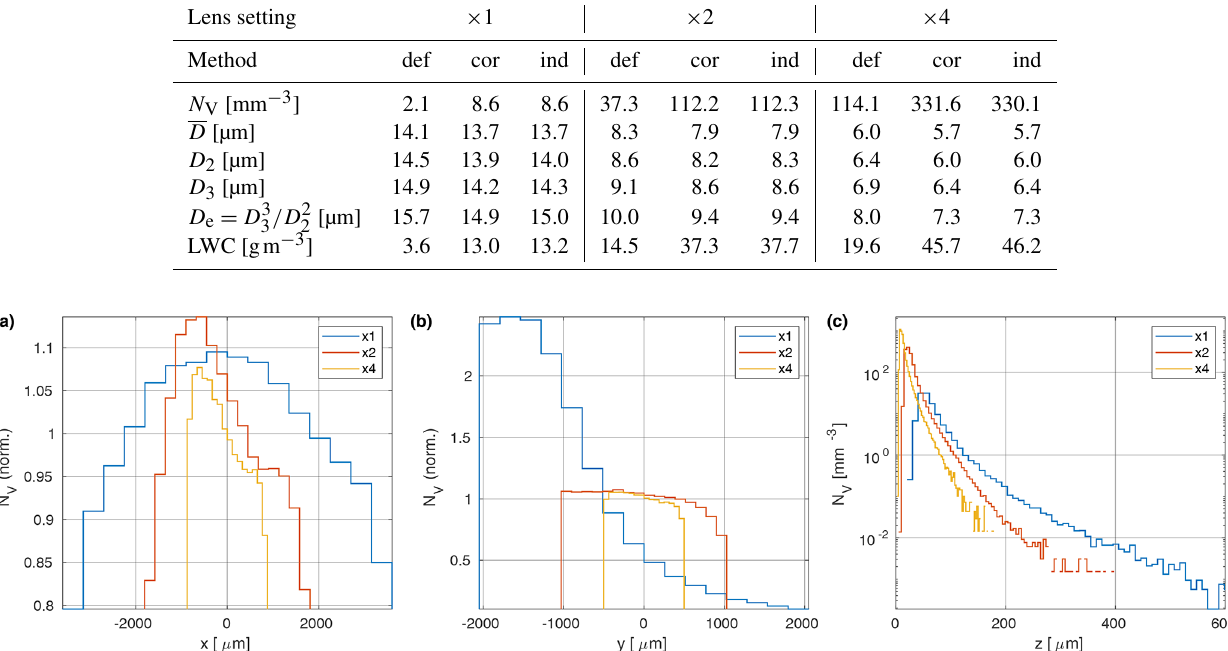
Figure 8. Dependence of the droplet concentration on the (a) horizontal, (b) vertical and (c) axial